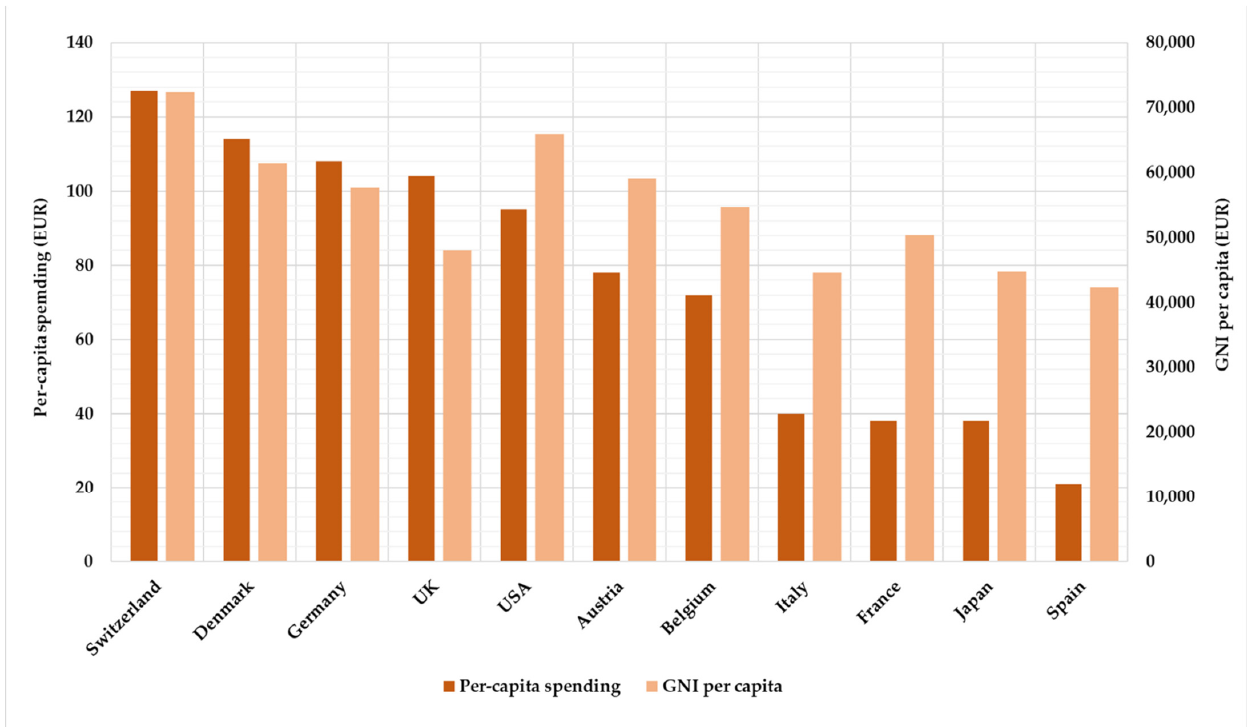
Figure 3. Consumption of flowers and plants (and related goods): per-capita spending and GNI in major world country markets (excl. China) (EUR). Source: our elaboration on [50]. The reported data do not include the share of spending concerning the market for services, e.g., floral and garden design, landscaping, green urban planning, green urban maintenance, etc. The data of per-capita spending refer to the latest available year in the timeframe 2015–2019. GNI = gross national income (at PPP = purchasing power parity) in 2016.